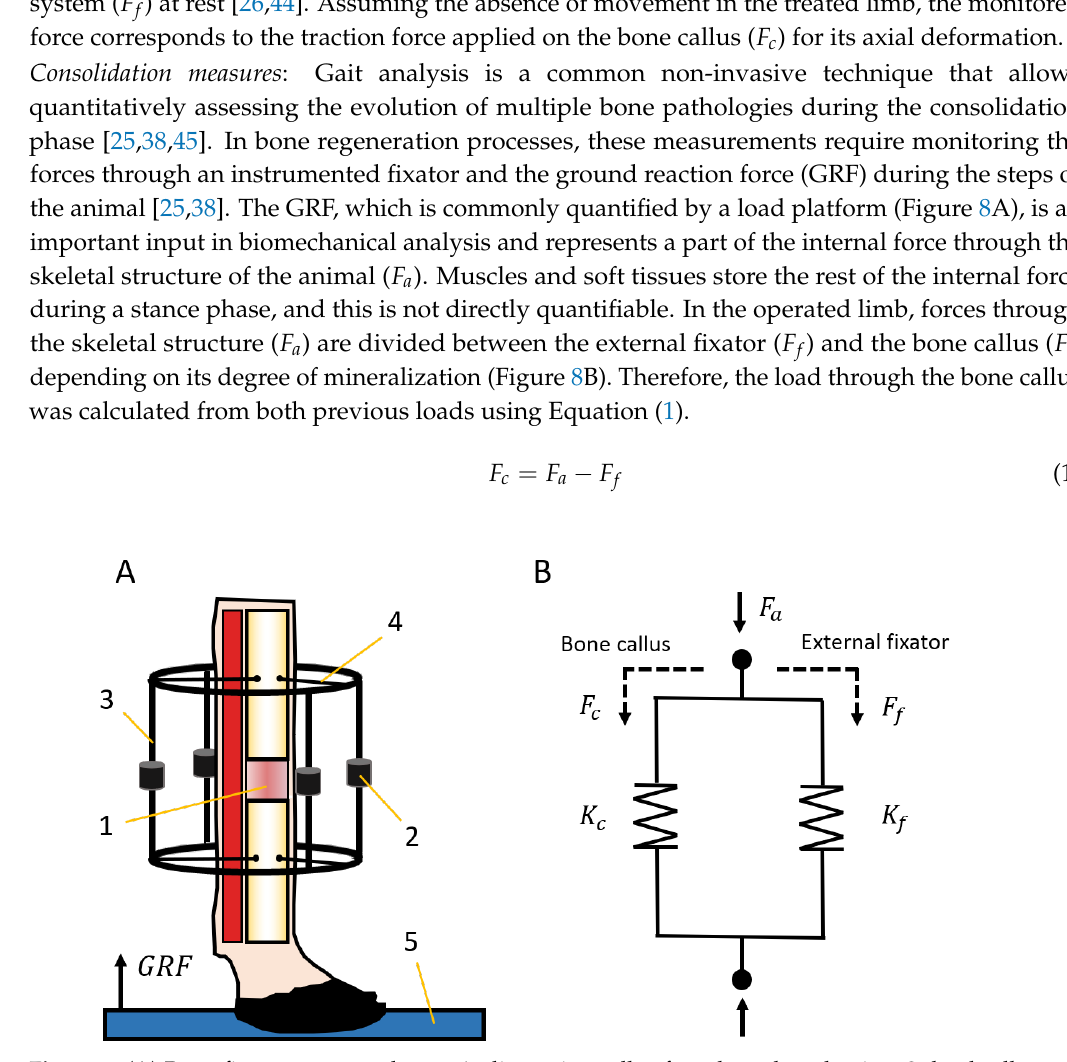
Figure 8. ( A ) Bone-fixator system scheme: 1. distraction callus from bone lengthening, 2. load cells, 3. external bars, 4. Schanz screws, 5. load platform. ( B ) Bone-fixator model: F a , external load